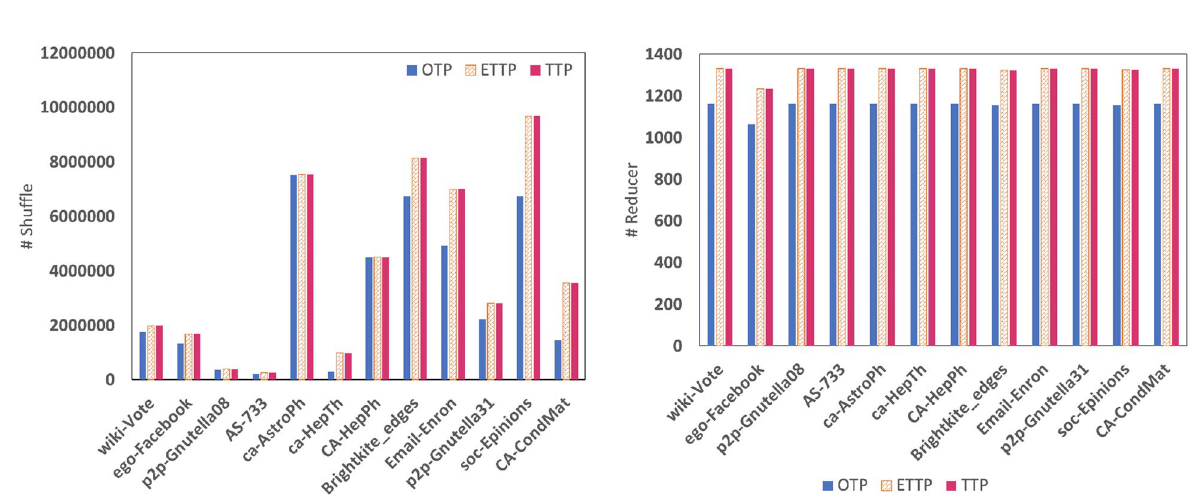
Figure 10. The workload of OTP, ETTP, and TTP